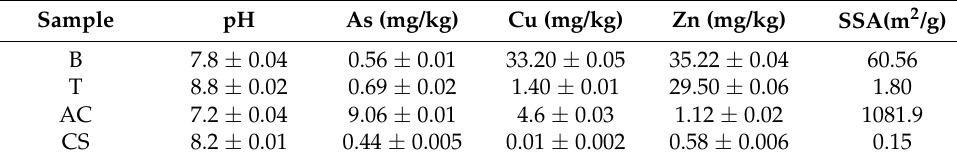
Table 3. Physicochemical properties of amendments.